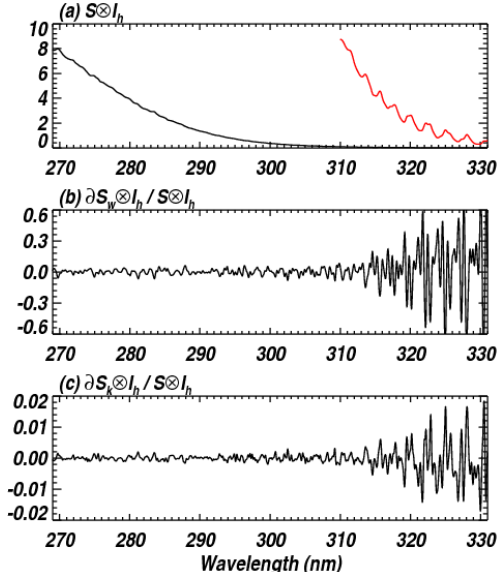
Figure 2. (a) Ozone absorption cross sections (cm 2 mol − 1 ) (δ h ) at different scales (red and black) at a representative tempera- ture (238.12K) calculated via convolution of a high-resolution (0.01nm) reference spectrum with the super Gaussian slit function, S ( k = 26, w = 026nm). (b–c) Its derivatives with respect to slit pa- ) , w and k , normalized to the convolved cross rameters (∂S p = ∂ ∂p